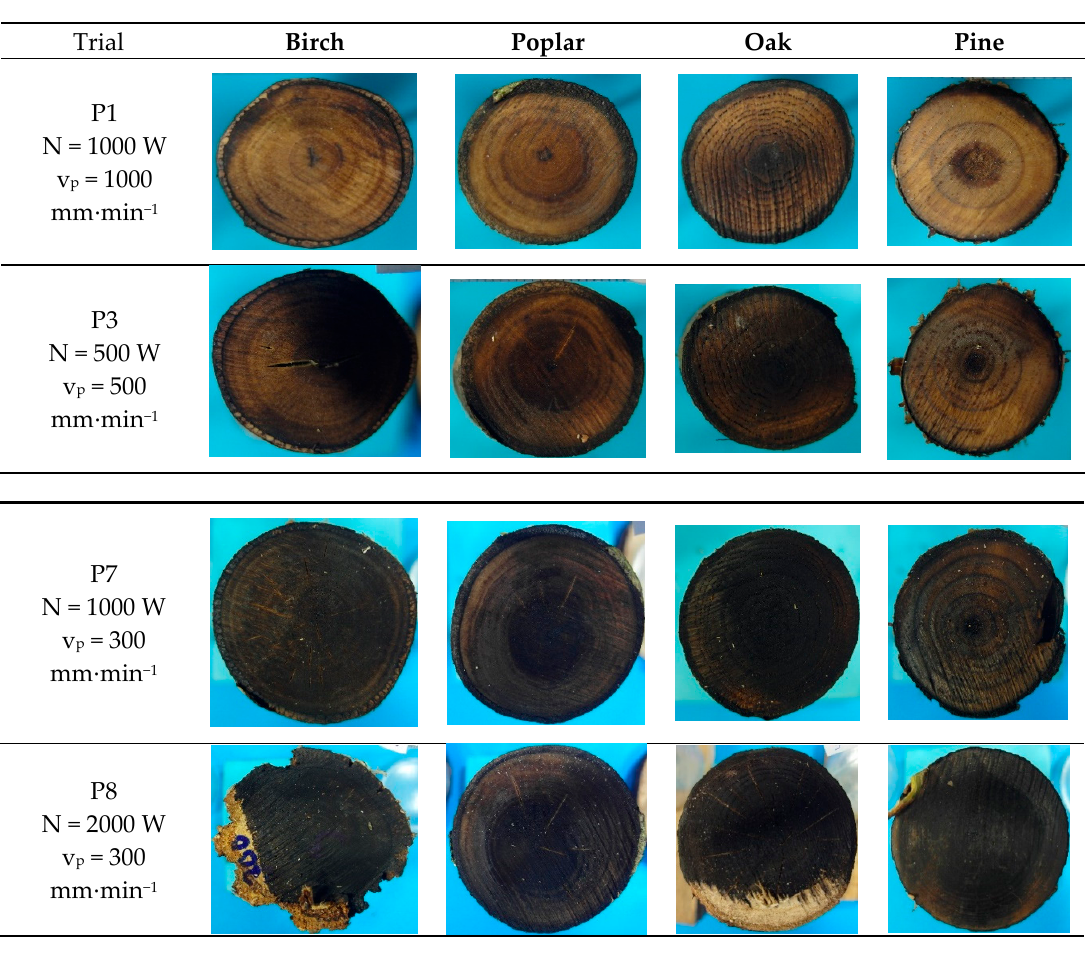
Figure 3. Cut surfaces at different laser beam powers and travel speeds.